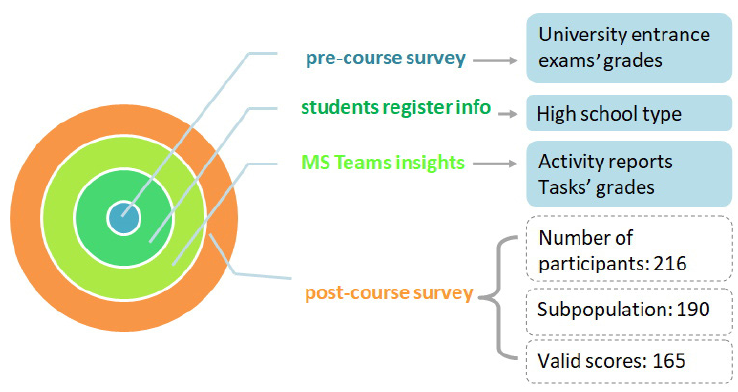
Figure 5. Organogram of the data collection method.